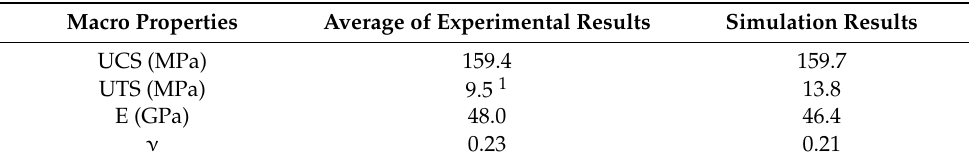
Table 2. Comparison of the Calibrated and Experimental Results of the Macro Mechanical Properties for Alax Porphyritic